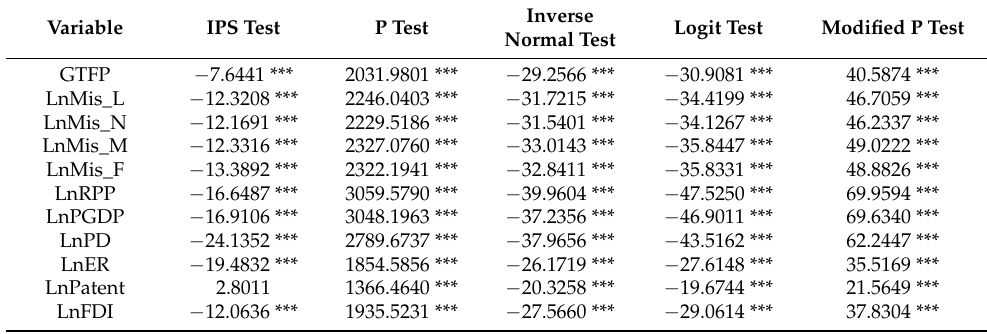
Table 1. Panel unit root tests results.